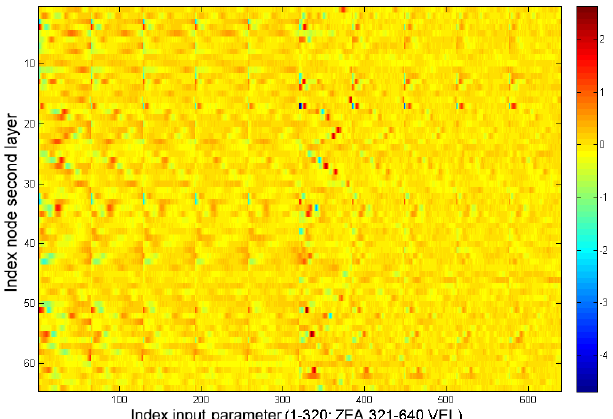
Figure 2. Neural network input layer